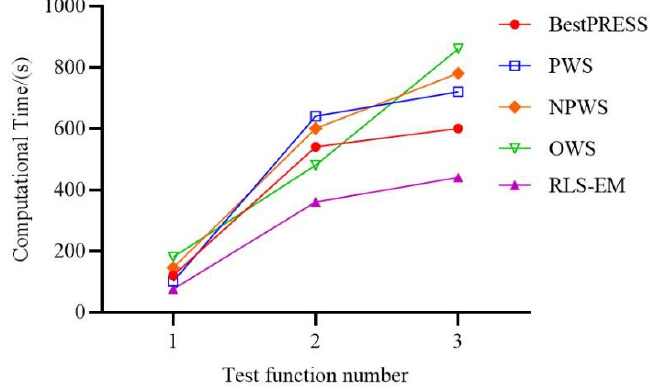
Figure 6. Comparison of computational time of ensemble models.